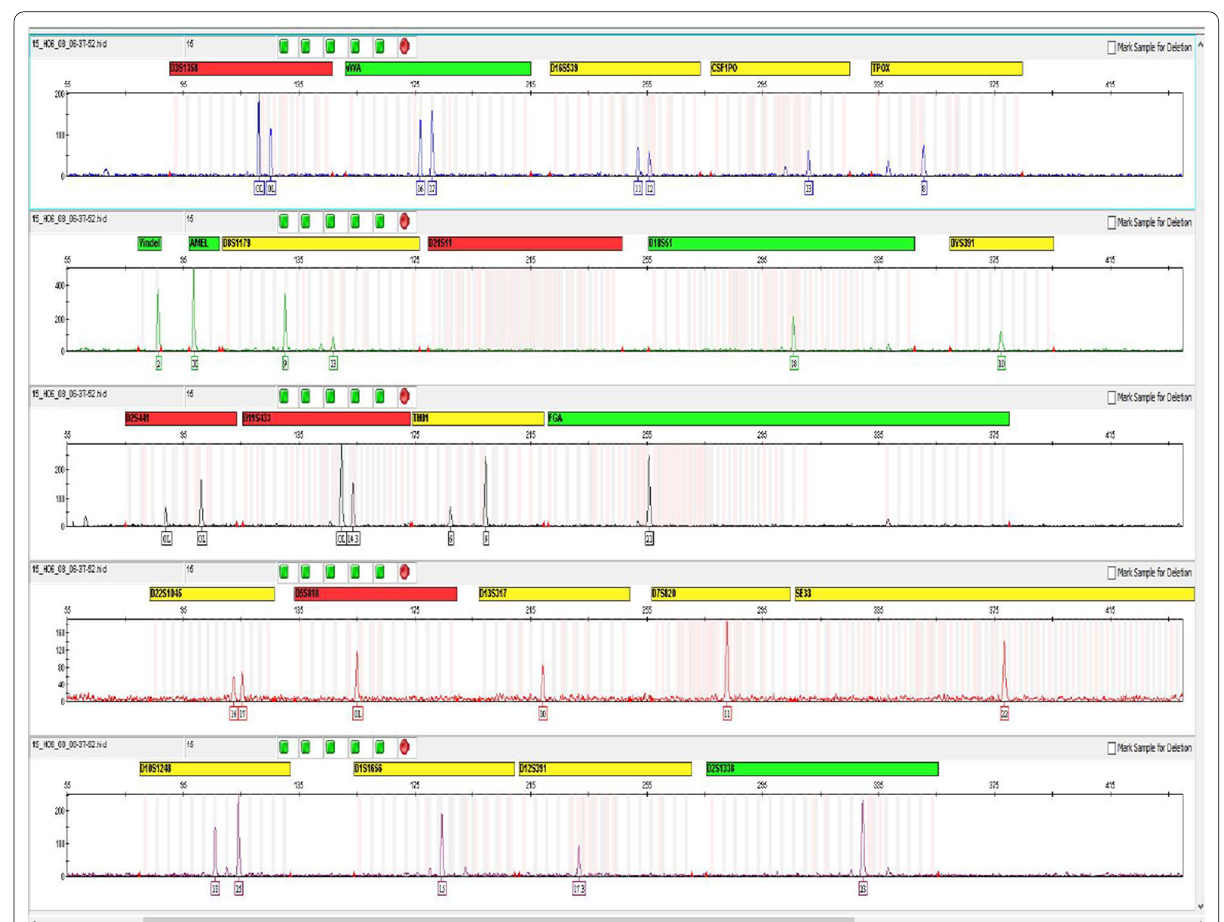
Fig. 5 DNA profile of blood stain in washed cotton fabric at 40 °C extracted by organic DNA extraction